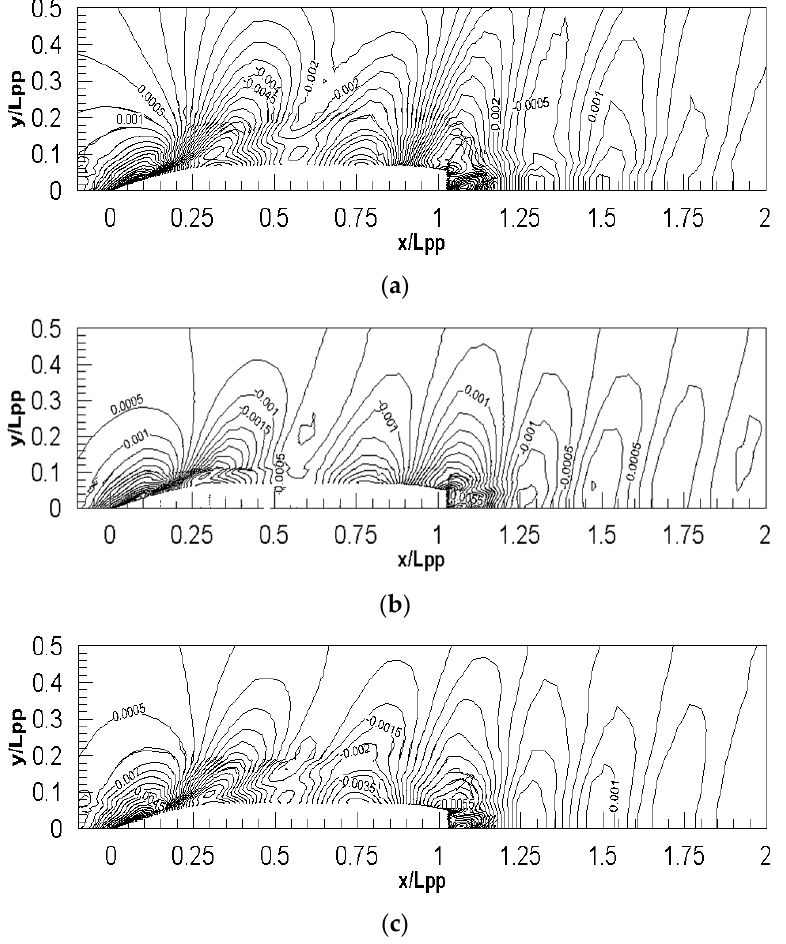
Figure 18. The overspeed ratios at different water depths for the 1:31.6 scaled model of the KCS (water depth decreases from top to bottom, corresponding to H = 4T, H = 6T, H = 8T, H = 10T respectively).